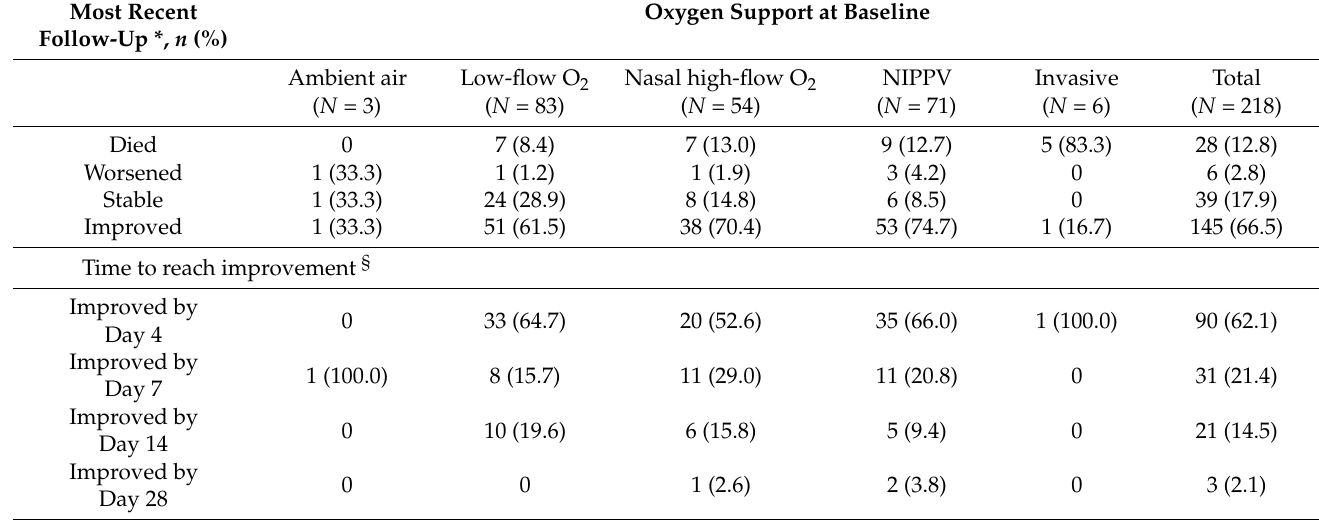
Table 3. Clinical status at the most recent follow-up and time to improvement according to the oxygen support group at baseline. One patient had missing information on oxygen support at baseline.